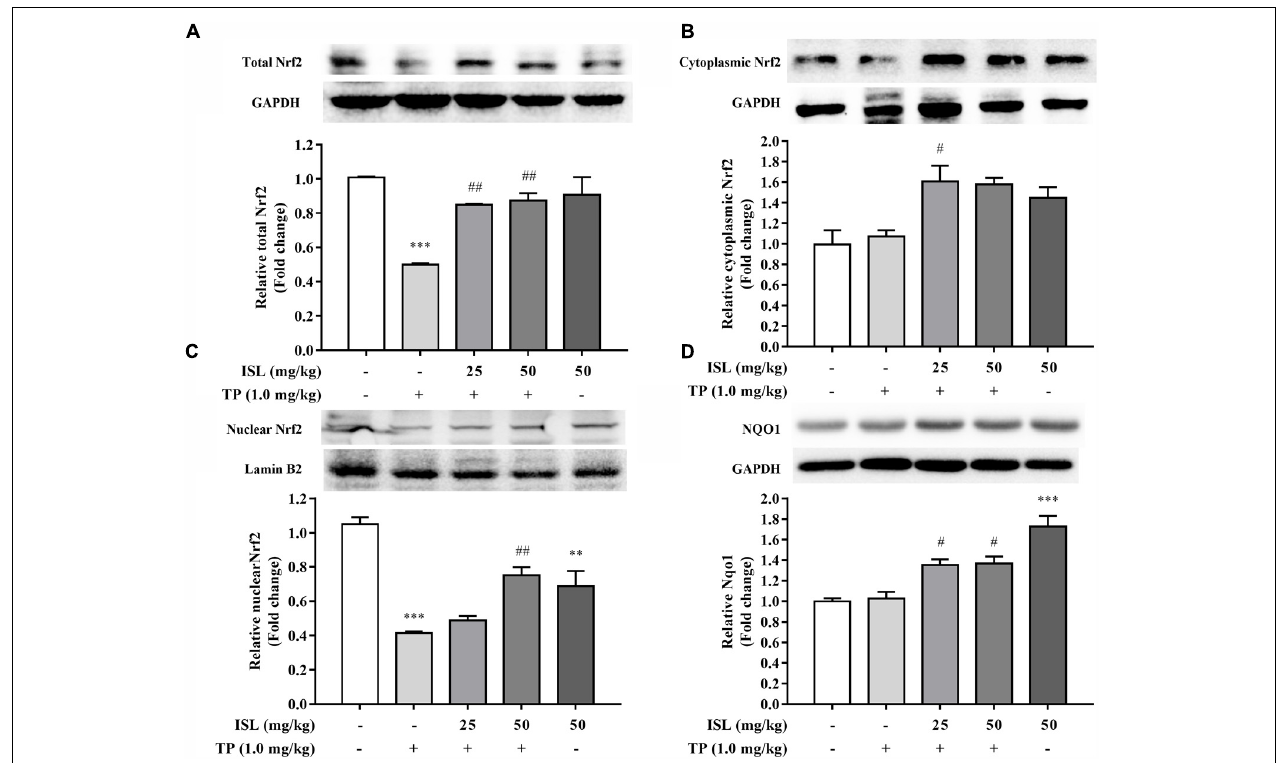
FIGURE 5 | Effects of TP, ISL, or ISL + TP on protein levels of (A) total, (B) cytoplasmic, and (C) nuclear Nrf2 and (D) Nqo1 in mouse livers. Cell lysates were analyzed by Western blot. Data were presented as means ± SE ( n = 5); ∗∗ P < 0.01 vs. the control group, ∗∗∗ P < 0.001 vs. the control group, # P < 0.05 vs. the TP group, and ## P < 0.01 vs. the TP